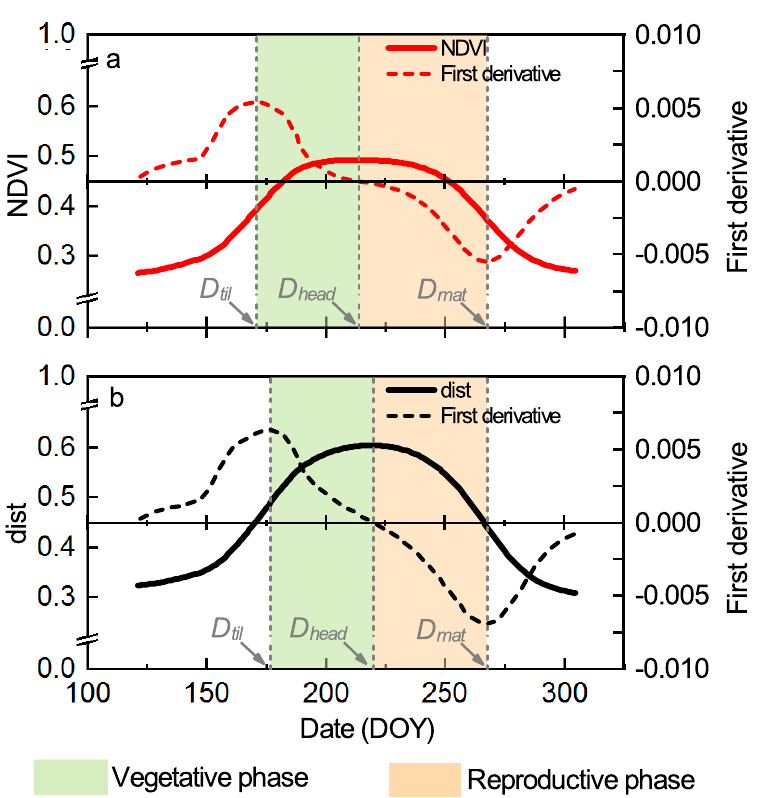
Figure 4. Temporal profiles and the first derivatives of NDVI ( a ) and dist ( b ). The vertical dashed lines refer to the dates of active tillering ( D til ), middle heading ( D head ), and maturity ( D mat ), from left to